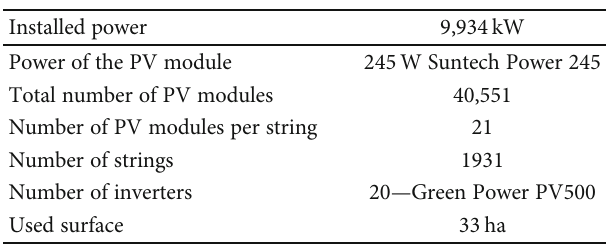
(b) Technical parameters of the PV modules — main components of